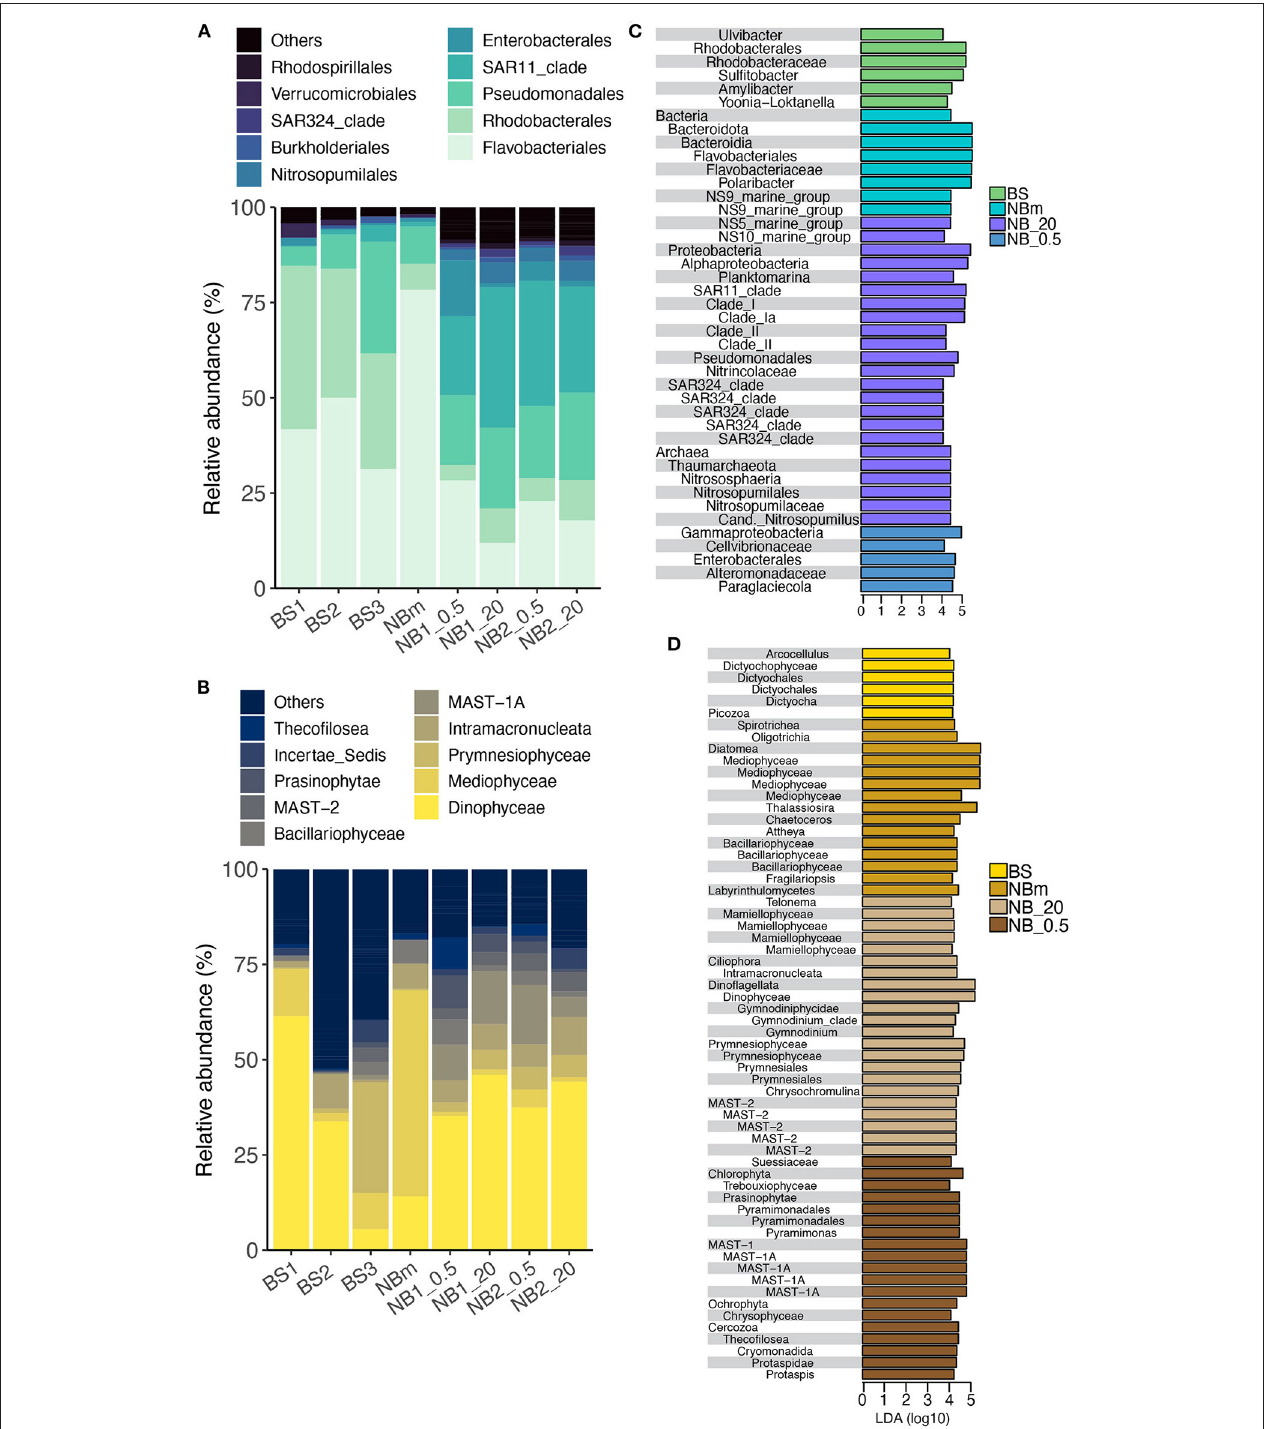
FIGURE 3 | Comparison of prokaryotic and microeukaryotic members of the surface marine microbiomes sampled across the study’s transect. The taxonomic profile of the most abundant prokaryotes (A) and microeukaryotes (B) retrieved from Amplicon Sequence Variants (ASVs) tables specified at the order and class taxonomic rank level, respectively. Prokaryotes (C) and microeukaryotes (D) identified from the LEfSe analysis at all taxonomic levels that describe the differences between each community grouped by environment type: BS, Barents Sea communities in open water environment; NBm, Nansen Basin margin community in sea-ice edge environment; NB_.5, Nansen Basin communities at the interface environment between sea-ice and surface water; NB_20, Nansen Basin communities in sea-ice covered environment. The x-axis is the LDA score (log 10) that indicates the scale of difference between groups.